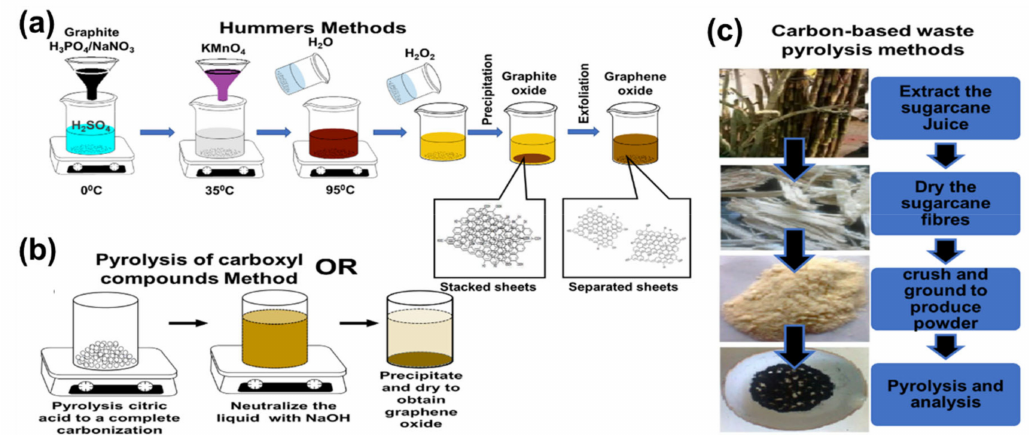
Figure 3. Schematics illustration for di ff erent synthesis of graphene oxide (GO): ( a ) Hummers method ( b ) pyrolysis of carboxyl compounds method and ( c ) pyrolysis of carbon-based